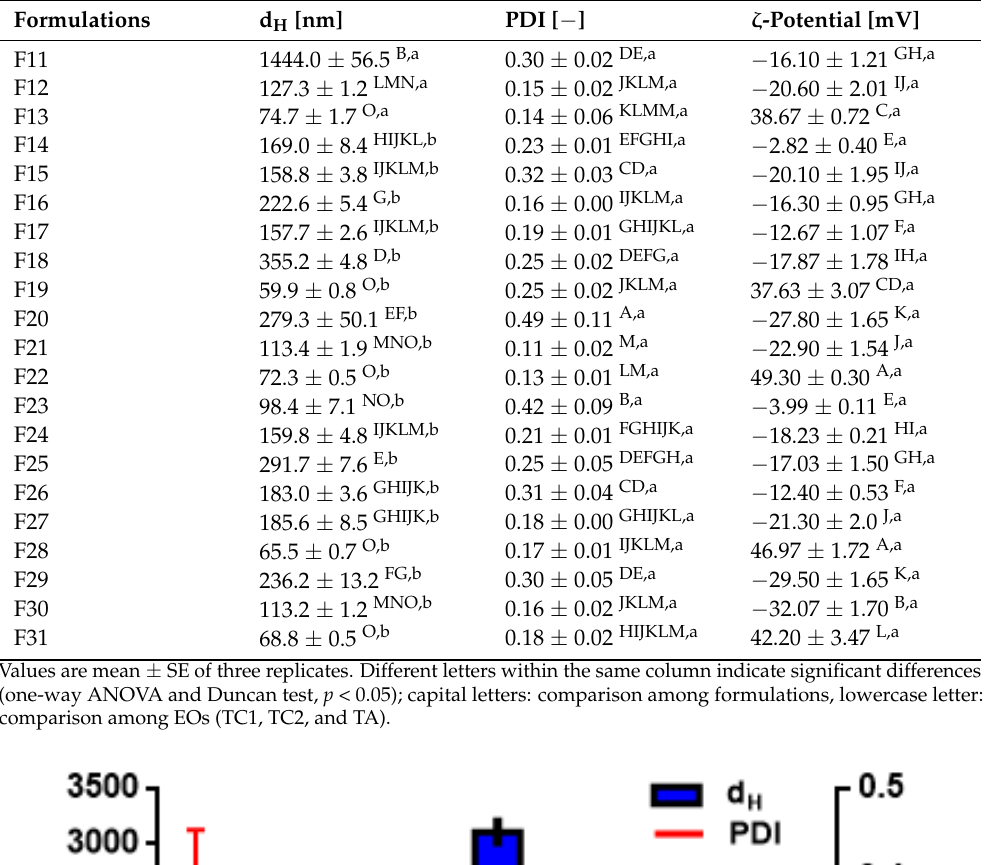
Figure 2. Hydrodynamic diameter (d H ) and polydispersity index (PDI) of TC1 EO nanoparticles (formulations F10–F13 in Table 1).